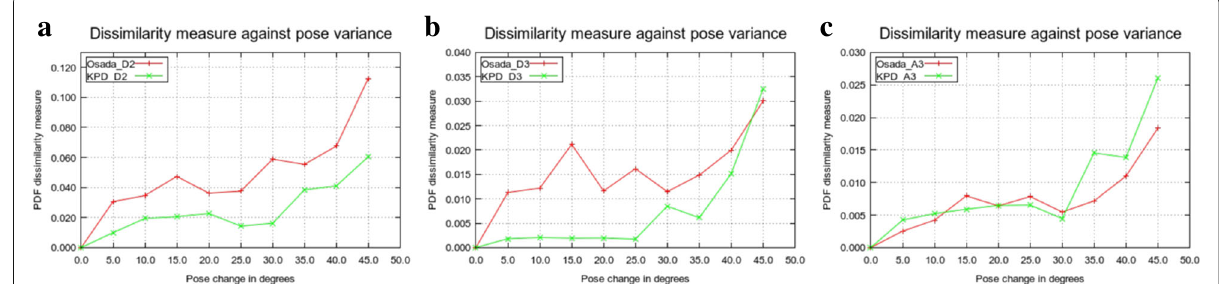
Fig. 16 Dissimilarity measure between the first view and the consecutive views acquired with 5° of rotation increment. Bhattacharya distance has been used to measure the dissimilarity. It can be seen that Osada’s shape functions (D2 and D3) have higher dissimilarity measures compared to KPD2 and KPD3 (see a , b ), and shape distributions change as the object is subjected to increase in pose change from master view ( c ) KPA3 and